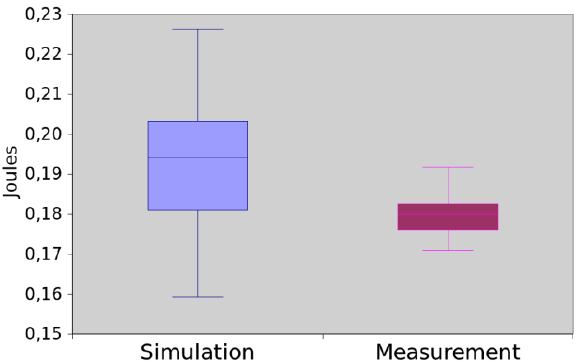
Figure 18. Power consumption of App5